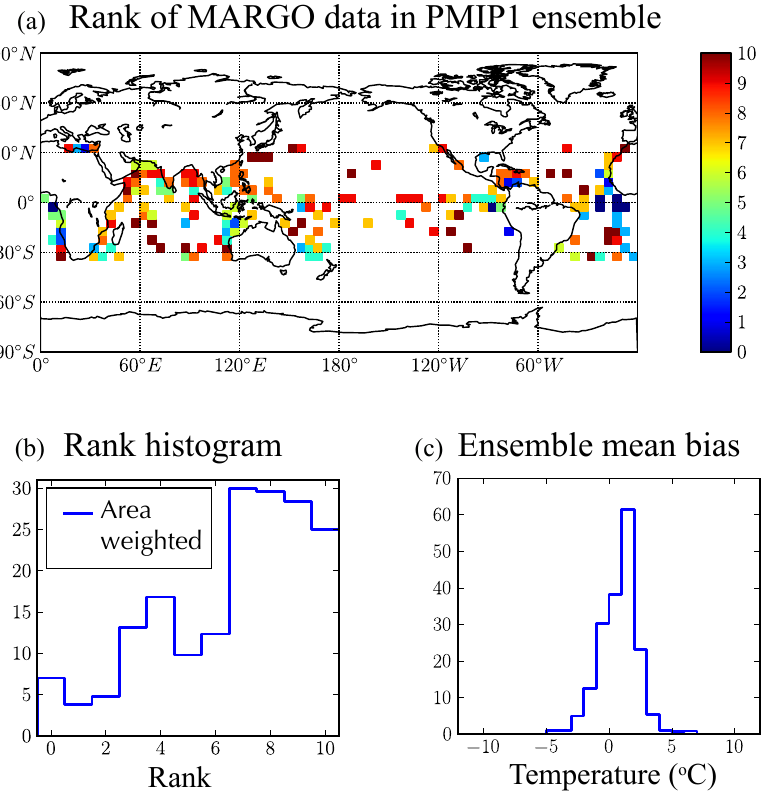
Fig. 3. (a) The rank of the MARGO data in the PMIP1 TAS for the range 35 ◦ S to 35 ◦ N. (b) Area-weighted rank histogram of the ranks in plot (a) . High rank (red on the colour scale) indicates that MARGO is warmer at the LGM than the ensemble. (c) The histogram of the difference between the PMIP1 TAS ensemble mean and the MARGO data for each data point in plot (a) . The uncertainties in the MARGO data are not taken into account Table 2. Statistics for the χ -square tests of uniformity, with and without including the MARGO data uncertainty estimates. p -values for statistical significance of non-uniformity for the rank histograms, following Jolliffe and Primo (2008). We specifically test for bias, V-shape (including the inverted V) and whether one or both end bins are significantly different from that expected for a uniform distribution. Total refers to the chi-square test on the full histogram.The bold font indicates those statistics which indicate a distribution significantly different from uniform at the 5%